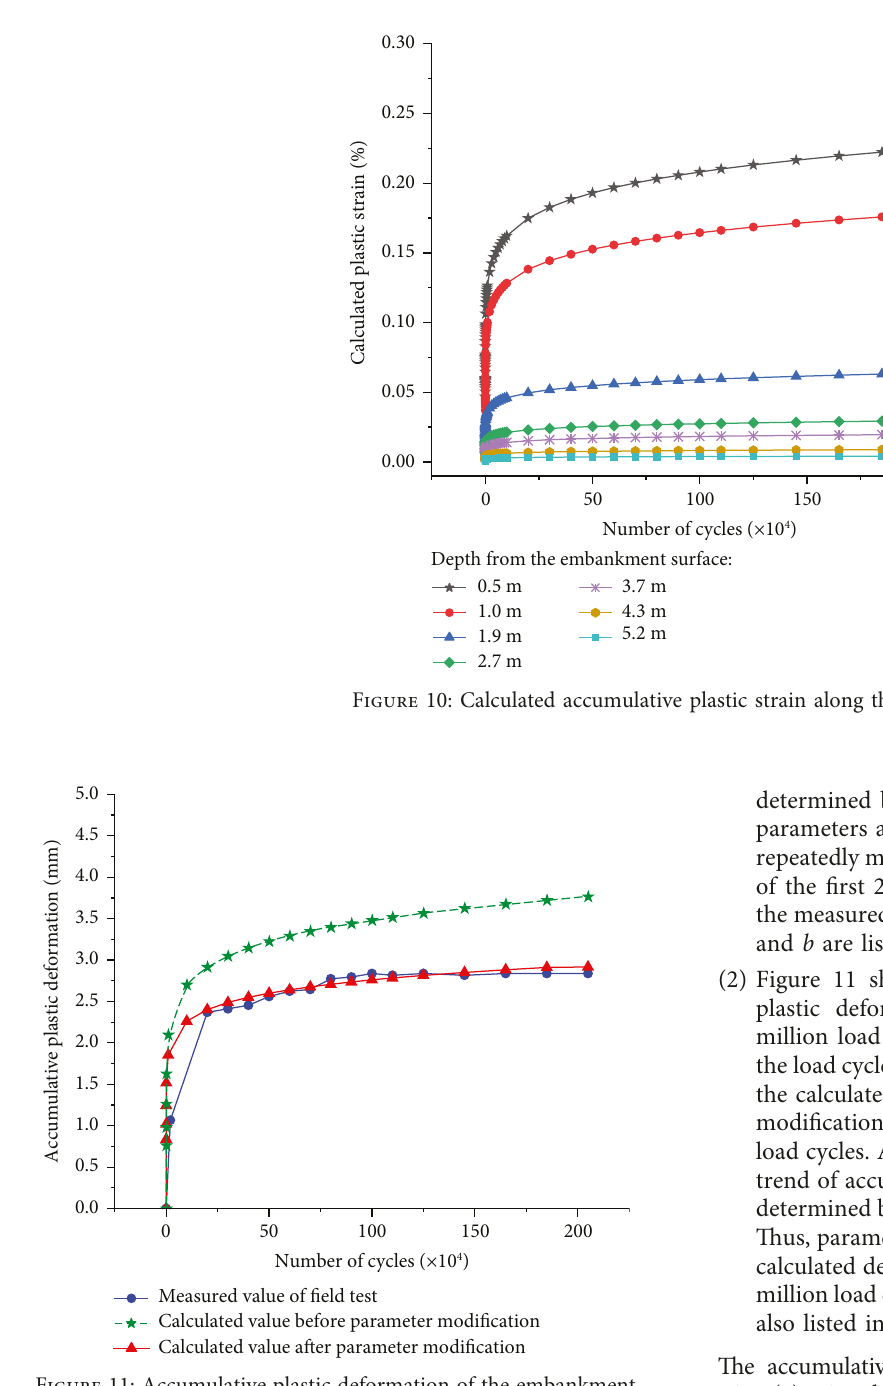
Figure 11: Accumulative plastic deformation of the embankment filled with the improved